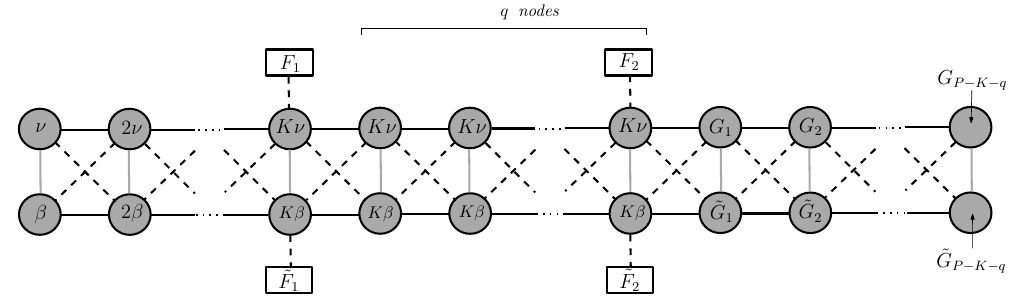
Figure 7 . The quiver encoding our third example. There are K gauged nodes with linearly increasing ranks in each row. These are followed by q (cid:0) SU( K(cid:23) ) (top row) and q (cid:0) SU( K(cid:12) ) nodes (lower row). The ranks of the next SU( G i ) and SU( ~ G i ) nodes is given in the text. The conventions for the (cid:12)elds running along the di(cid:11)erent lines are the same as those in section